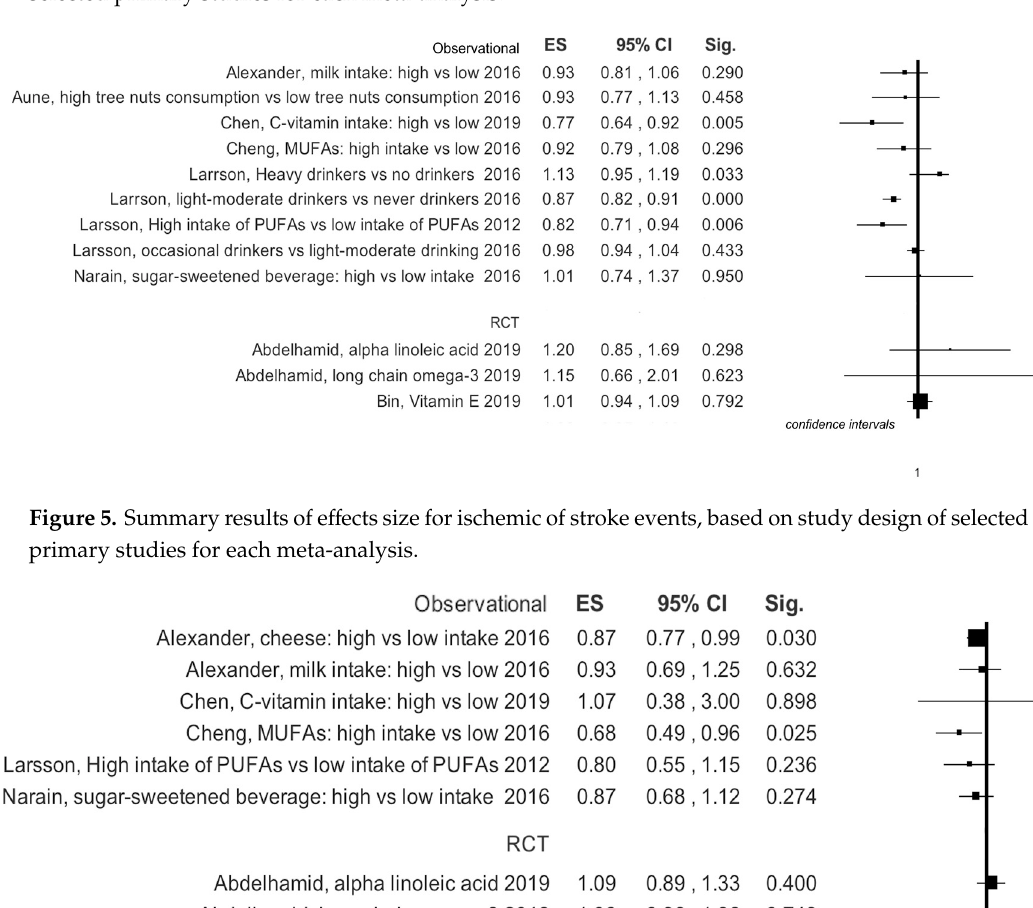
Figure 4. Summary results of effects size for any type of stroke events in RCT, based on study design of selected primary studies for each meta-analysis.